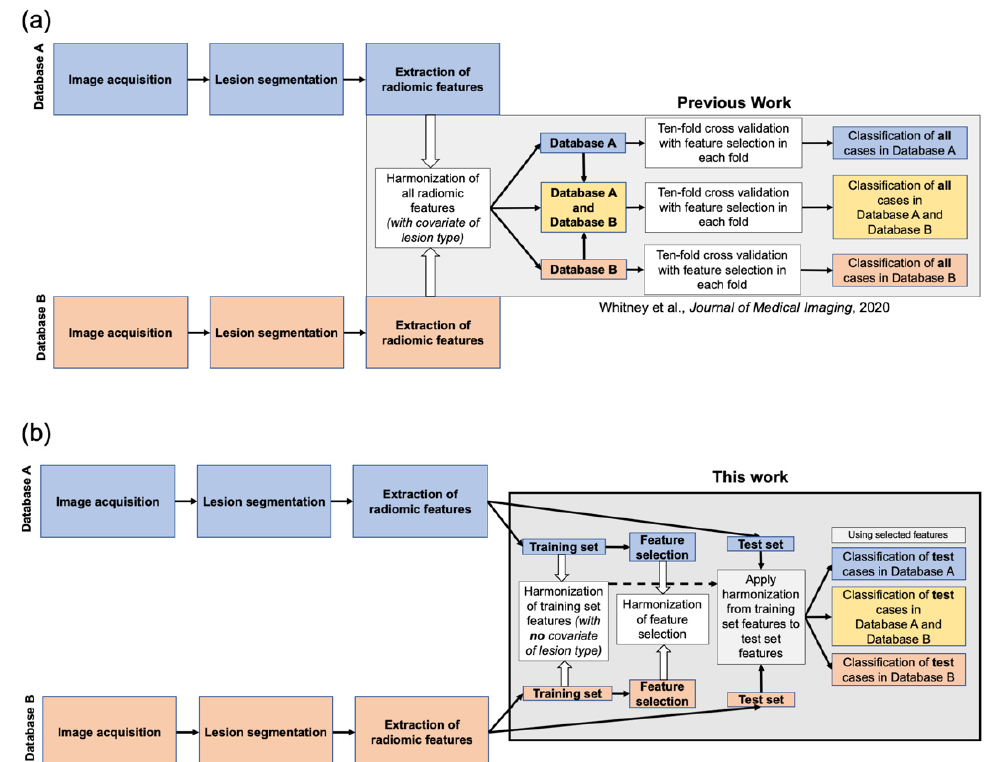
Figure 1. Illustration of two stages in an AI/CADx medical imaging workflow where harmonization can be applied. ( a ) Previous work investigated the impacts of batch harmonization in a single stage of all features in the two databases with covariates in the context of cross-validation (Whitney et al., Journal of Medical Imaging 2020 [5]). ( b ) This present work investigates both batch harmonization of features and harmonization of feature selection in a training and independent test framework (i.e., harmonization is conducted on the features of the lesions in the training set and separately applied to the features of the lesions in the test set), with no covariates.